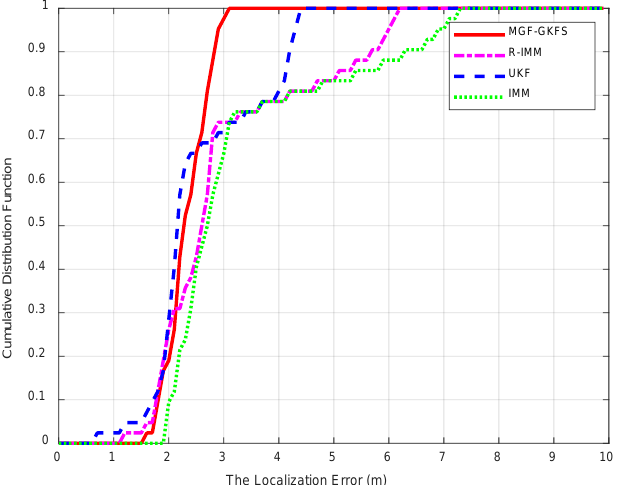
Figure 15. The CDF versus the localization errors. Table 3. Total number of